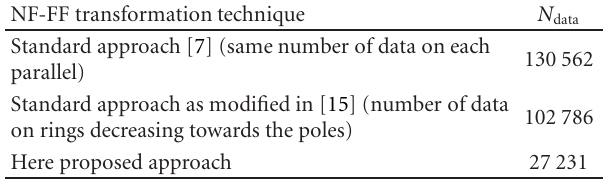
Figure 5: Amplitude of the output voltage V (cid:2) on the meridian at ϕ = 90 ◦ . Solid line: exact. Crosses: interpolated.